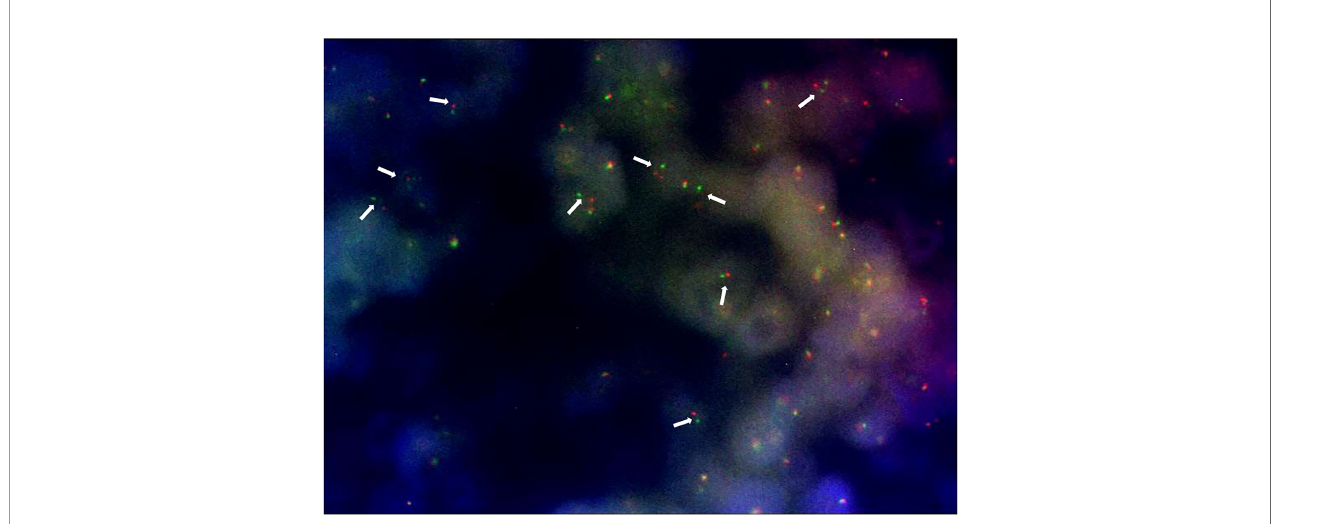
FIGURE 3 | FISH - EWSRI Break Apart FISH Probe Kit (locus